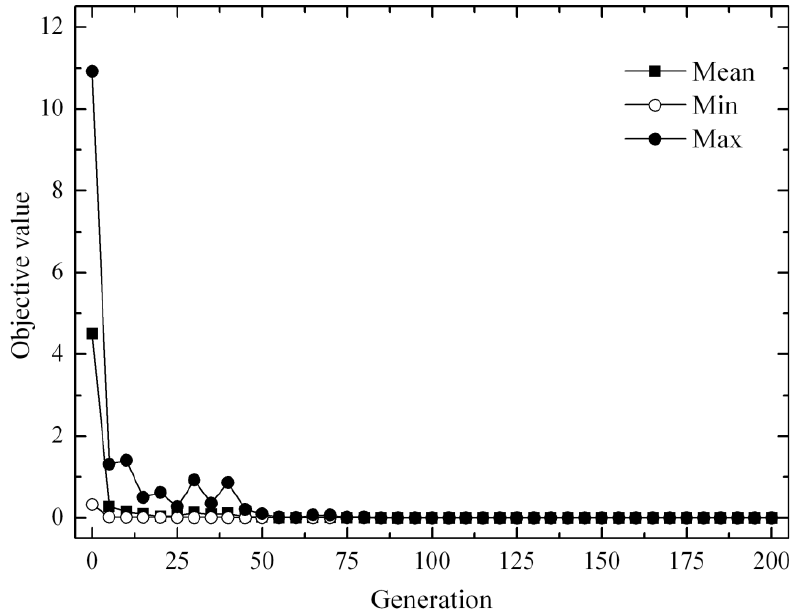
Figure 4. The minimum (Min), mean (Mean), and maximum (Max) objective values of all the individuals in each generation during the iteration process.